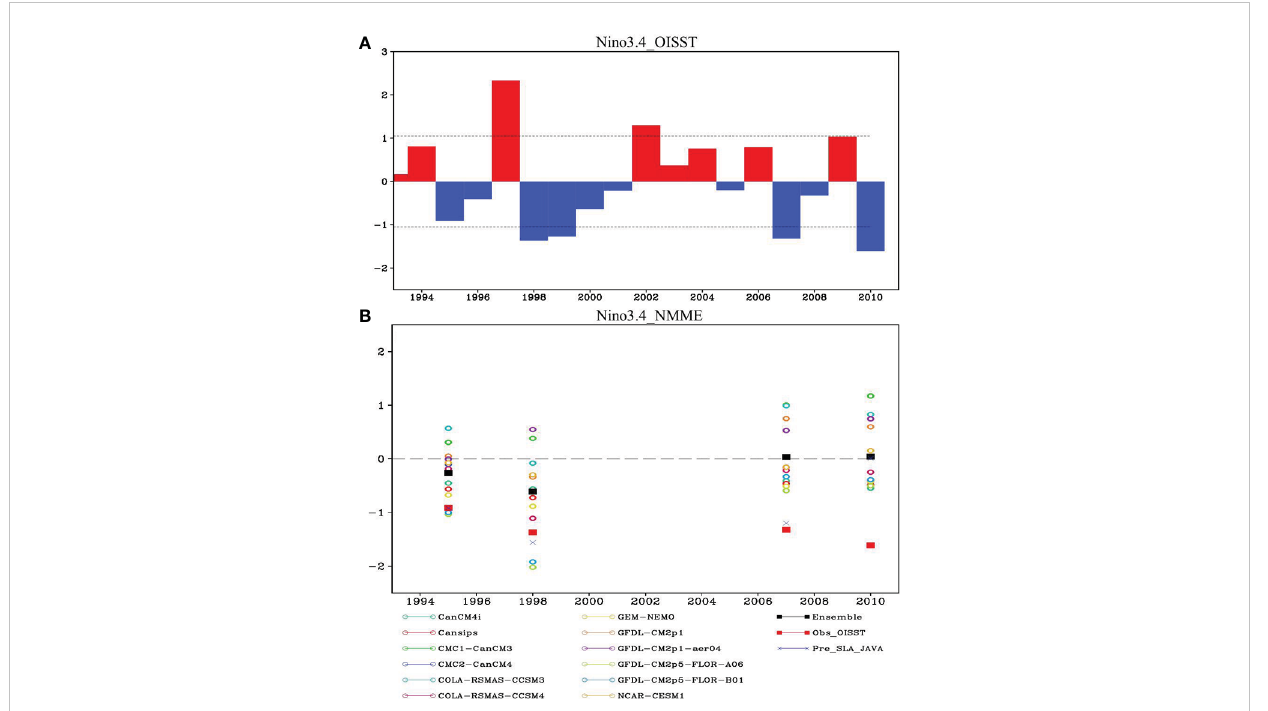
FIGURE 9 Forecasts of the historical strong La Niña events from 1993. (A) The fall Niño3.4 index (°C) from the OISST data for the 1993-2010 period. (B) The fall Niño3.4 index of NMME model and multi-model mean forecasts (at lead 11.5 months) for 1993-2010. The Niño3.4 index based on observations is also shown for reference (red squares). Blue crosses denote the predictions of the fall Niño3.4 index using the linear regression model with the fall SLA in the SETIO as the precursor.